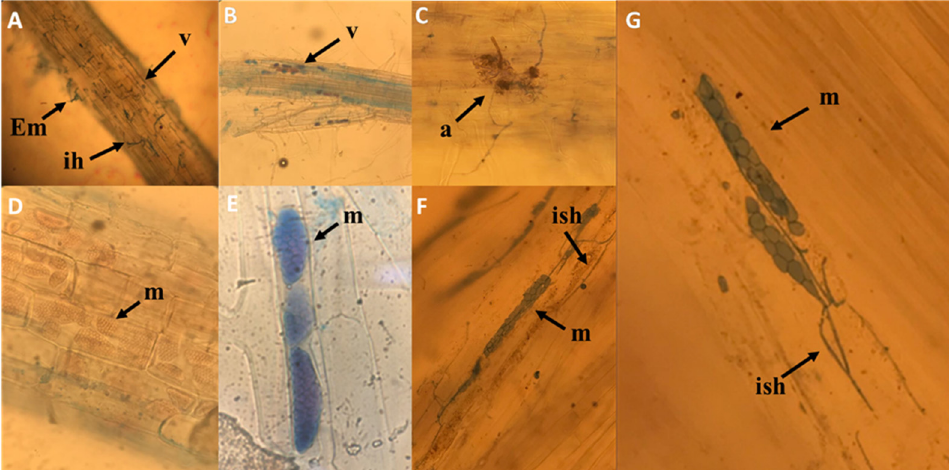
Figure 5. Light microscopy of root colonization by mycorrhizal fungi and DSE. Vesicles and arbuscules ( A – C ); intracellular growth of endophytic fungus with stained microsclerotia at the young stage (arrowhead) in cortical cells without and with trypan blue ( D – G ). Em= external mycelium; ih = intracellular hyphae; v = vesicles; a = arbuscule; m = microsclerotia; ish = intracellular septate hyphae.